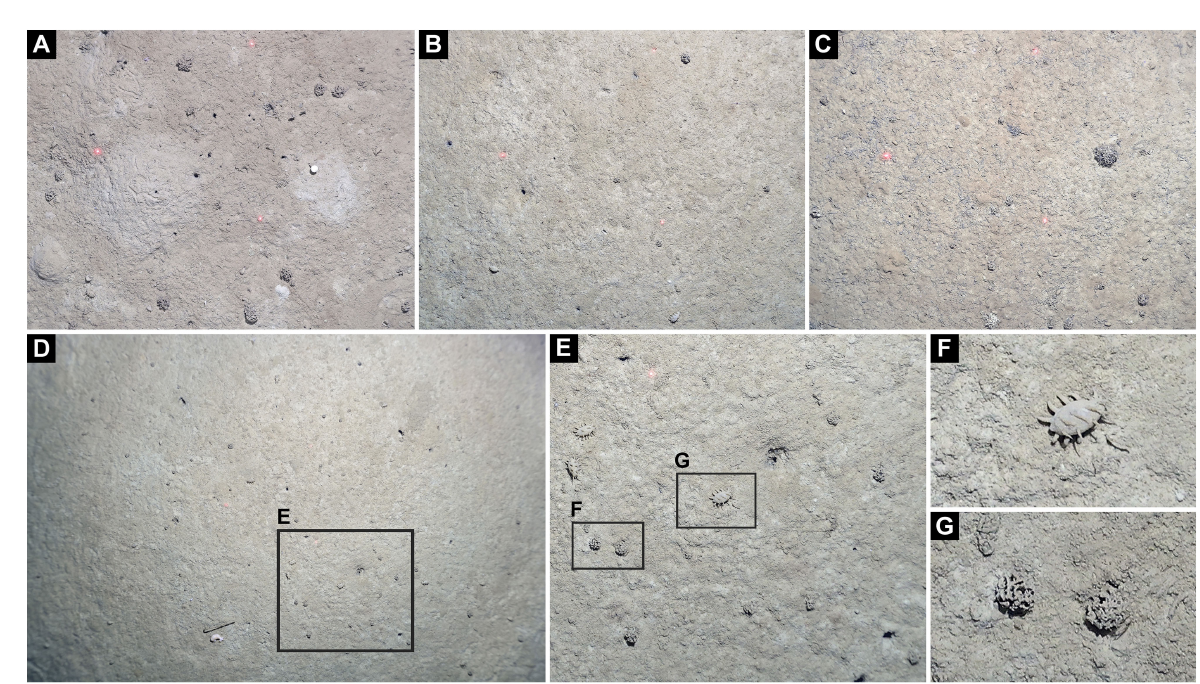
FIGURE 1 Representative OFOS sea fl oor still images of the Bering Sea sites. (A – C) Cropped centre portion of exemplary images from station 1, 2, and 3, respectively, each showing the same area of 0.9 x 0.7 m as calibrated by the laser pointers. (D) Example full-frame image of the Bering Sea used for quantitative analysis from station 2 at 54°32.19 ’ N, 174°37.50 ’ W, depth 3653 m. Total frame of 2.1 x 1.4 m with a usable in-focus area of 1.79 m 2 , including one Abyssocucumis sp. as well as 13 Elpidia minutissima holothurians and 22 xenophyophores. (E) Inset, showing clear, representative images of target taxa, (F) . Elpidia minutissima , (G) . reticulated xenophyophores ( Syringammina limosa